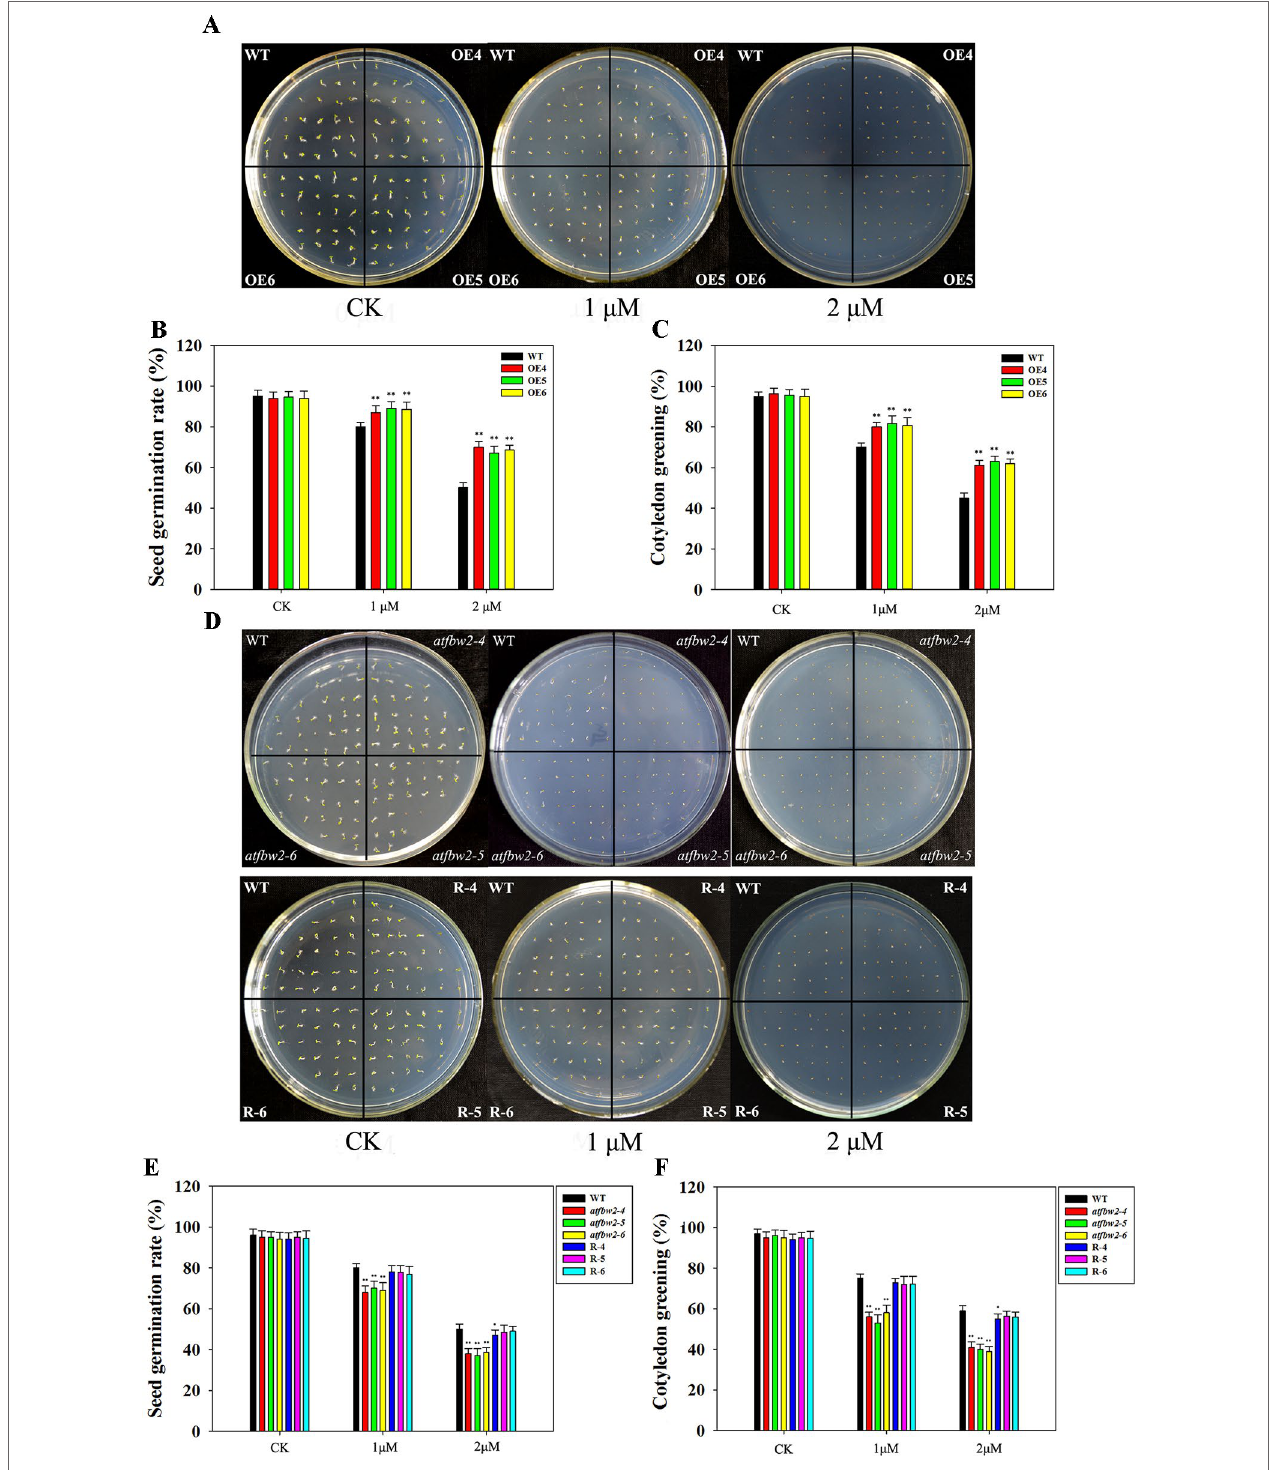
FIGURE 5 | Germination and cotyledon greening rates of Arabidopsis plants following ABA treatment. (A) Germination phenotype, (B) germination rates, and (C) cotyledon greening rates of OEs (OE4, OE5, OE6) and WT lines in different concentrations of ABA. (D) Germination phenotype, (E) germination rates, and (F) cotyledon greening rates of WT, mutant ( atfbw2-4 , atfbw2-5 , atfbw2-6 ), and recovery plants (R-4, R-5, R-6). Germination rates were measured 4 days after sowing, and cotyledon greening rates were measured at 7 days after sowing. Data represent mean ± SE of three biological replicates. * P < 0.05; ** P <